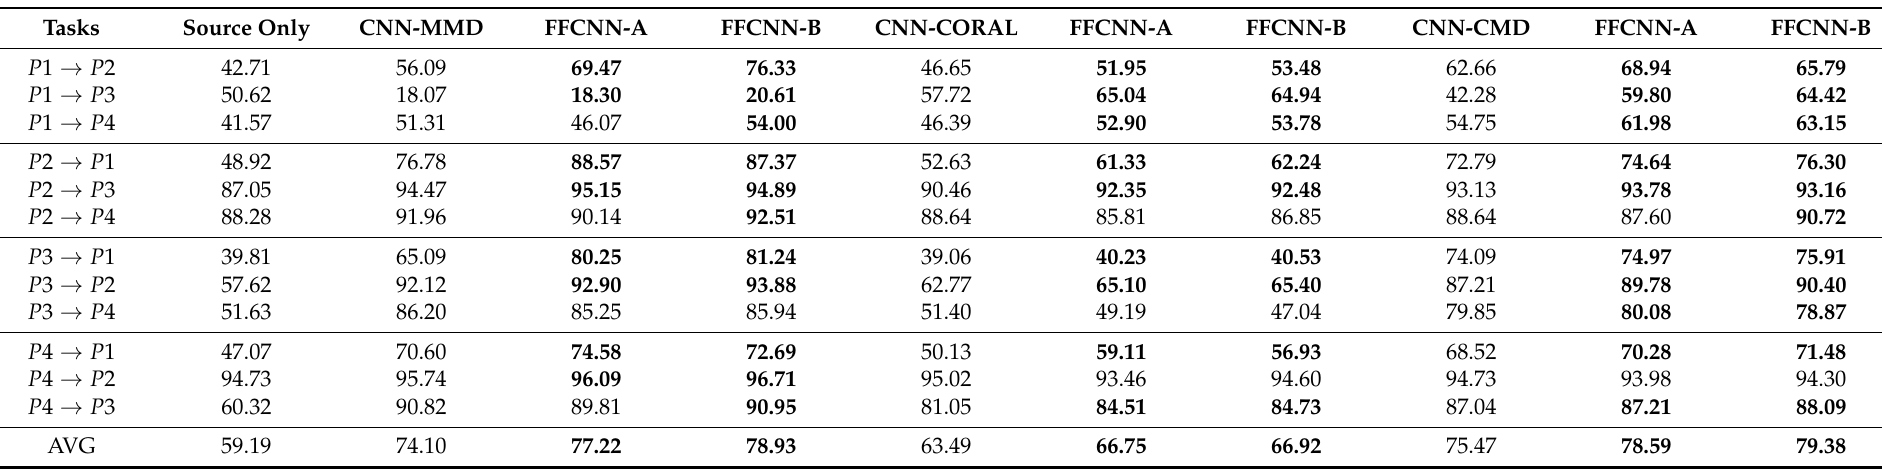
Table 5. Diagnosis accuracy (%) on different working conditions compared with different methods using Paderborn dataset. The values in bold indicate that FFCNN has a higher accuracy rate than